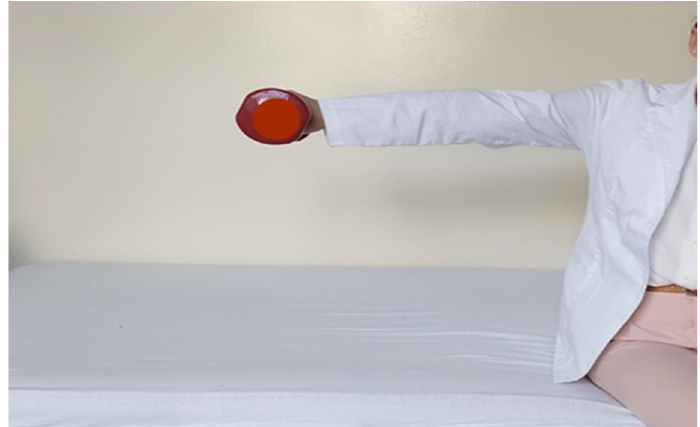
Figure 1. Sustained (30-s) deltoid contraction obtained by holding a 3-kg dumbbell weight.